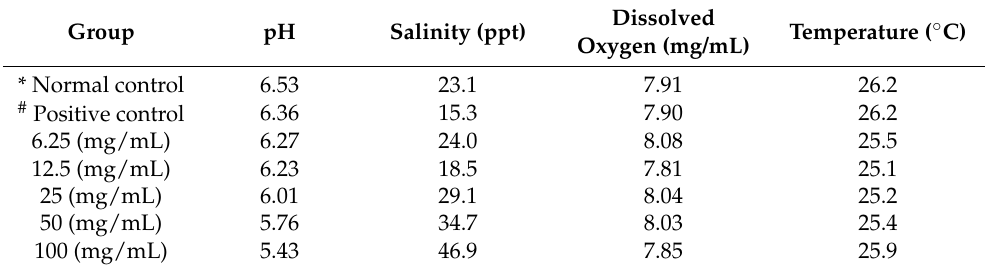
Table 2. Water quality parameters of the solutions applied for the fish treatment. Group pH Salinity